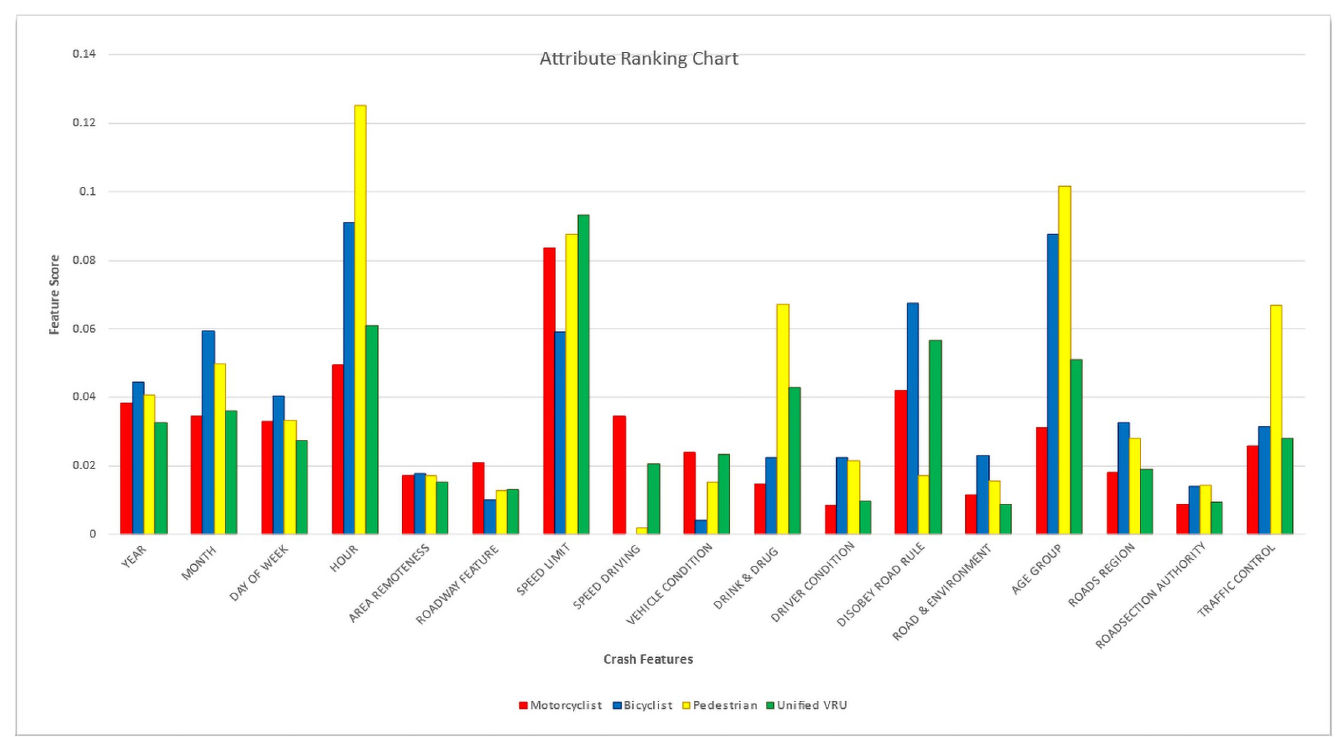
Fig 4. Random forest based feature ranking for QLD